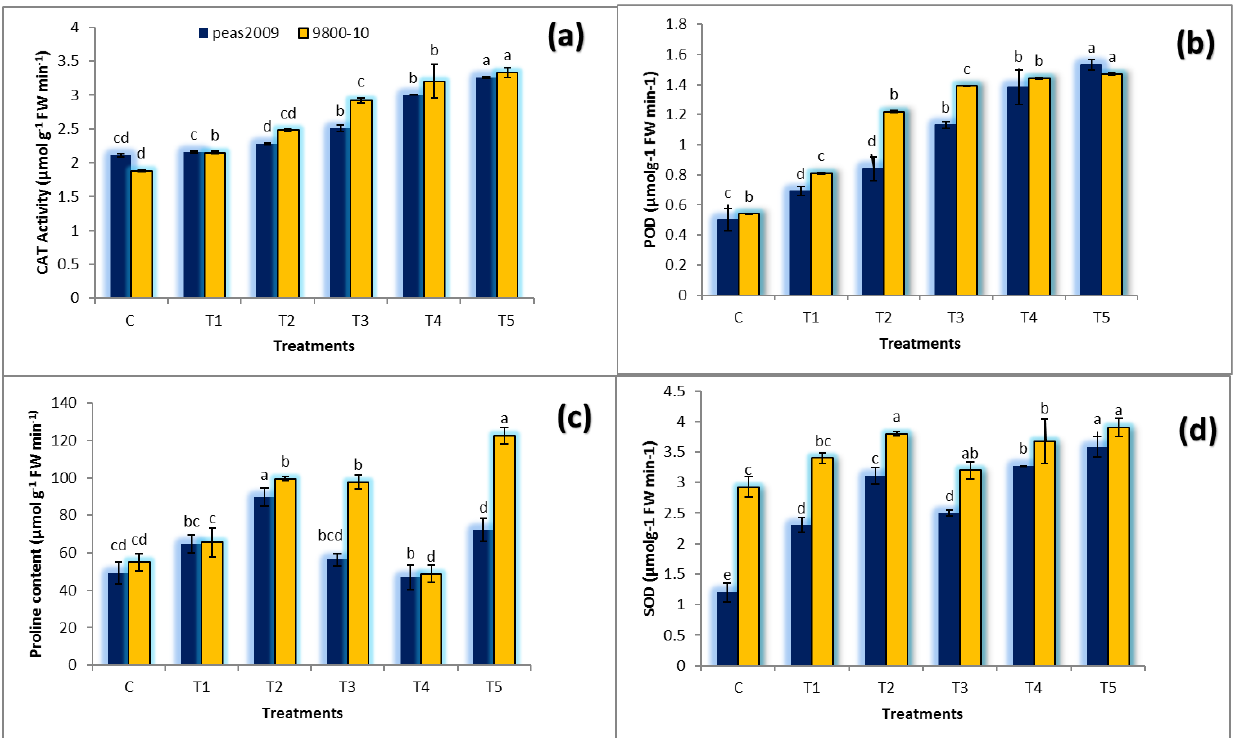
Figure 3. Effect of K. rhziophilla 14asp on antioxidants ( a ) Catalase, ( b ) peroxidase, ( c ) proline content, and ( d ) superoxide dismutase activities in leaves of pea plants under a saline regime. Each treatment is presented as mean values of triplicate data ( n = 3) with standard error (S.E). C represents uninoculated control, T1 (75 mM NaCl), T2 (150 mM NaCl), T3 (inoculated with K. rhizophila ), T4 (75 mM NaCl + K. rhizophila ), and T5 (150 mM NaCl + K. rhizophila ). Different letters on means of treatment shows significant difference at p < 0.05.